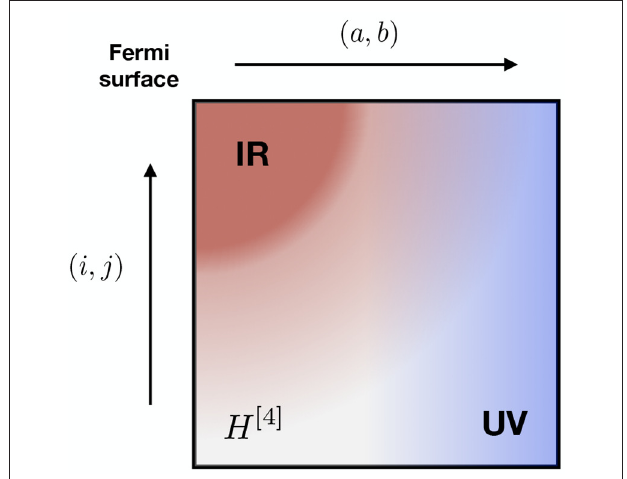
FIGURE 1 | Schematic matrix representation of the residual nuclear two-body interaction at play in perturbation theory. The size of the matrix elements is proportional to the darkness of the pixel while the red (blue) color indicate schematically a negative (positive) sign. In the present case, typically associated to MBPT on top of a closed-shell Slater determinant, the IR (UV) couplings translate into large negative (positive) matrix elements between pairs of unoccupied and occupied states near the Fermi level (between any pairs of occupied and highly excited virtual